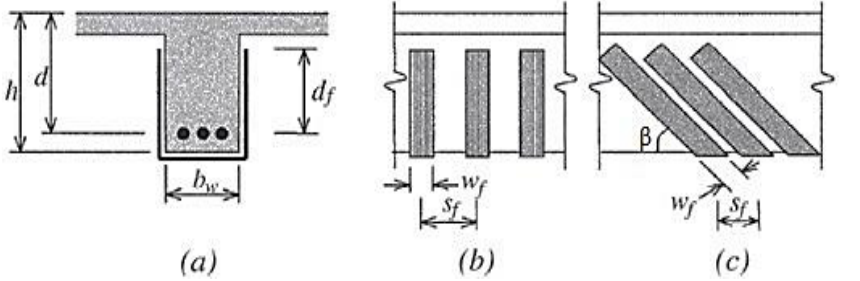
Figure 1. Variables used in the ACI 440.2R model for shear-strengthening calculations ( a ) cross-sectional parameters ( b ) spacing and width of FRP ( c ) inclination angle between FRP strip and beam axis.